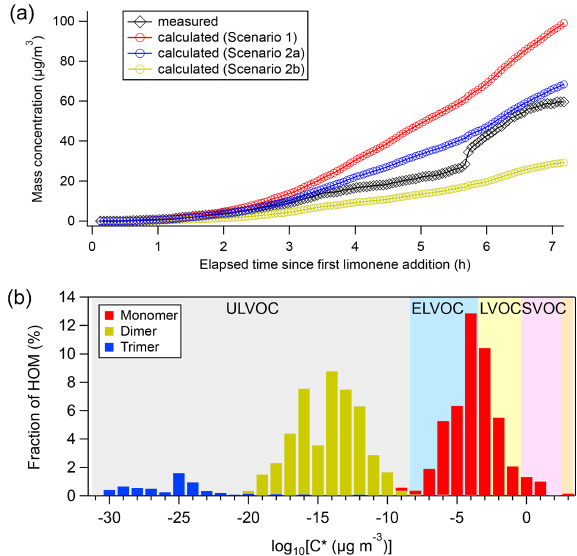
Figure 7. (a) Comparison of measured particle concentrations (black) against those predicted from condensation of measured HOM on aerosol particles, where red markers were calculated un- der scenario 1, and blue and yellow markers were calculated under scenario 2 (only considering the condensation of ULVOC, ELVOC, and LVOC), with the volatility calculated using the method by Mohr et al. (2019) scenario 2a) and Peräkylä et al. (2020) (scenario 2b) re- spectively. (b) HOM volatility distribution using formula provided by Mohr et al. (2019). Average concentrations of HOM in the P1 period were used to calculate the fraction of